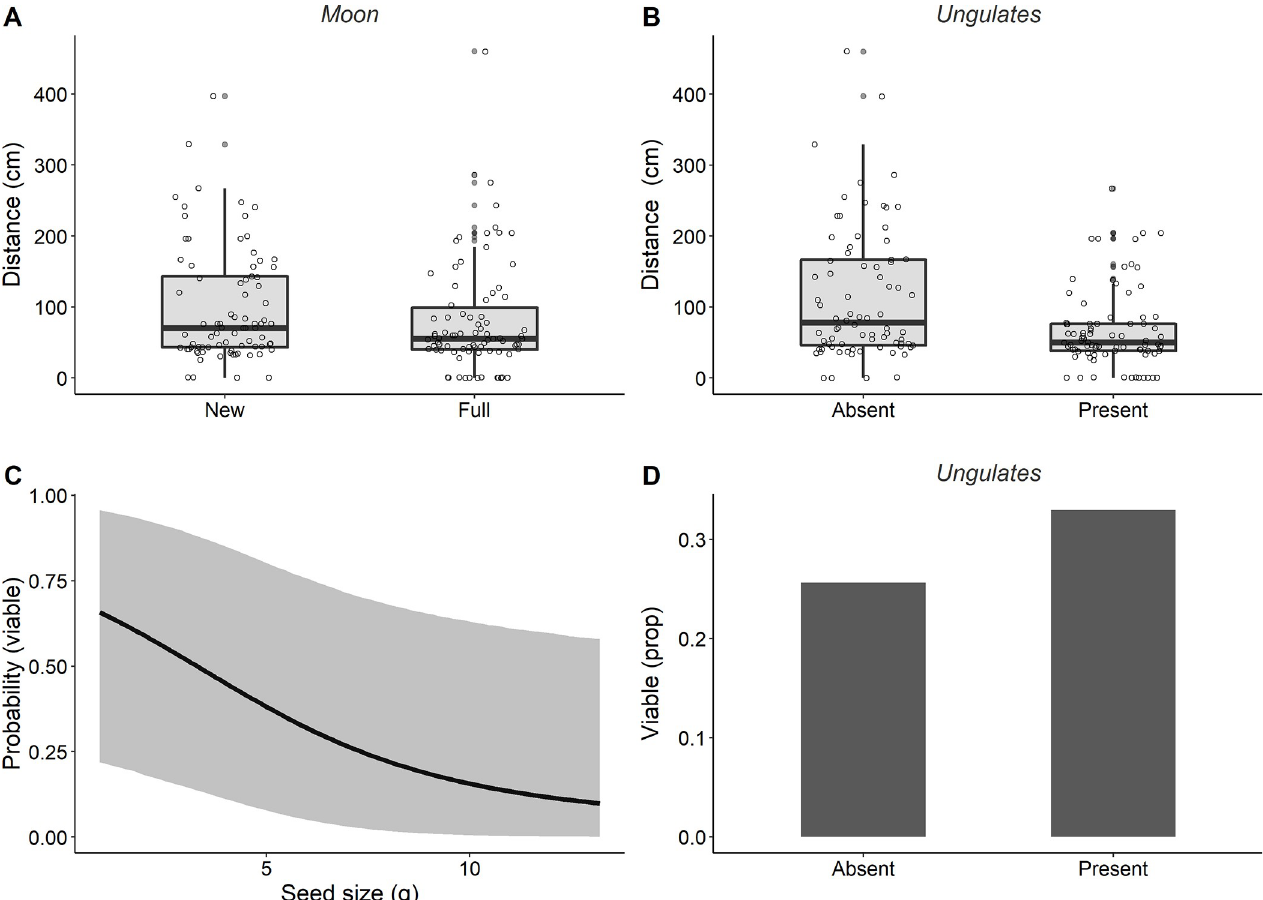
Fig 2. Mouse foraging decisions during transportation and after deposition (upper and lower panels, respectively). Removal distances under (A) new and full moon conditions and (B) in the absence and presence of ungulates. (C) Seed size effects on the probability of predation after deposition (black line represents mean effects and shaded area 0.95 credible intervals). (D) Proportion of acorns escaping predation after deposition in the absence and presence of ungulates. Sample size was 267 for mobilization distances and 211 for analyses of initial seed fate.